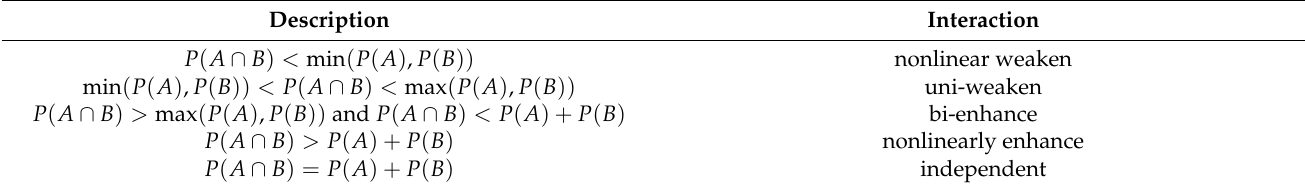
Table 2. Definition of interaction